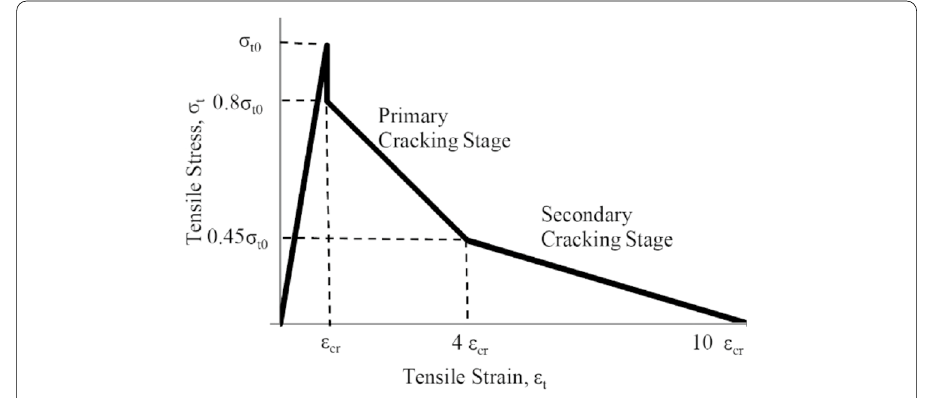
Fig. 4 Modified tension stiffening model [36]